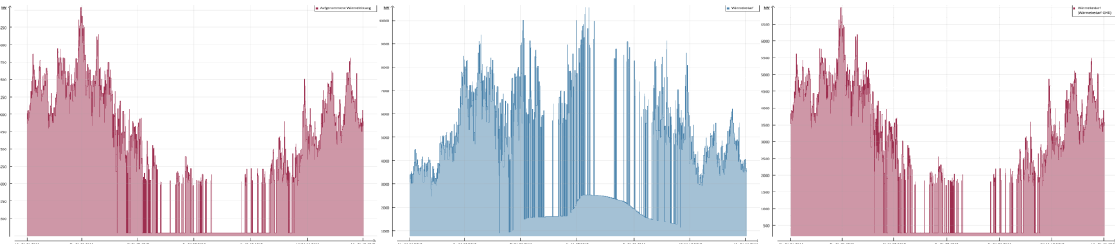
Figure 5. Time series for power demand per sector in TopEnergy software. Left: Private sector; middle: tourist’s sector; right: commercial